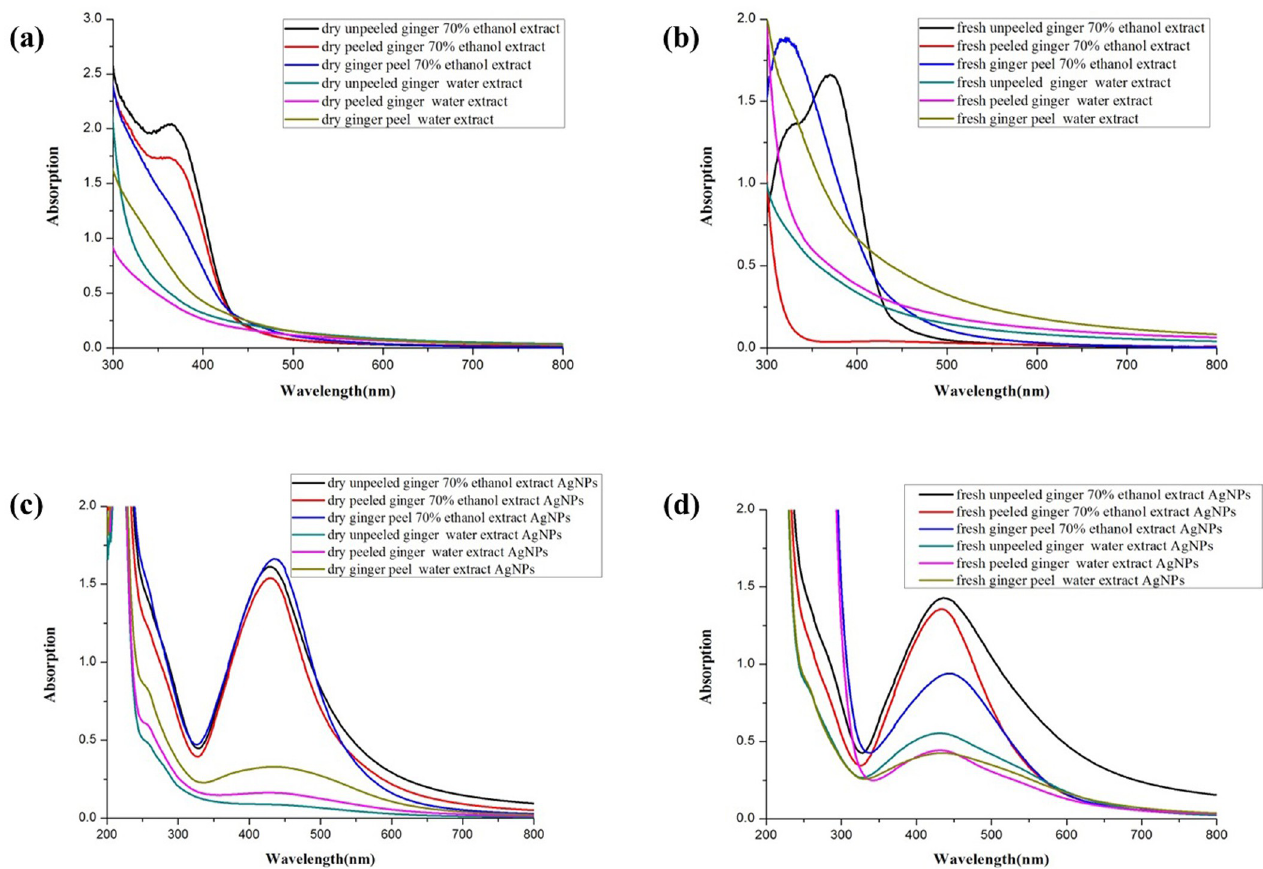
Fig 2. UV-vis spectra of the Z . officinale root extract and synthesized Z . officinale AgNPs: (a) dry ginger extract; (b) fresh ginger extract; (c) dry ginger extract AgNPs; (d) fresh ginger extract AgNPs.